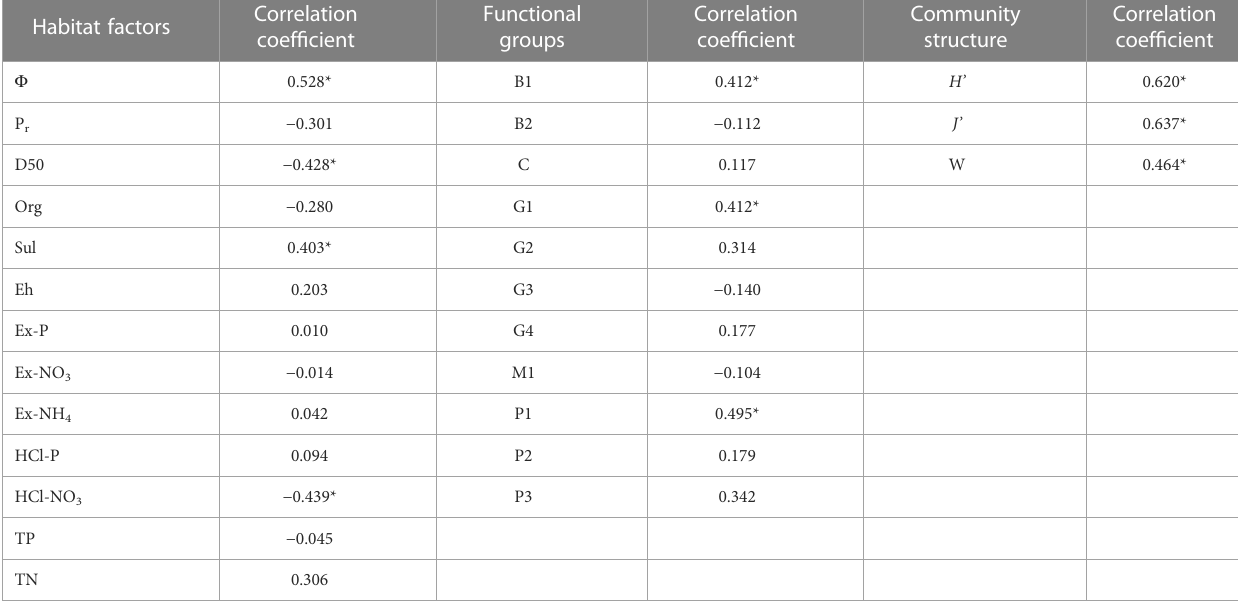
TABLE 6 Correlation of Manila clam and other functional groups, habitat factors, and community structure (M represents the biomass of Manila clam; j , Pr, D50, Org, Sul, Eh, Ex-P, Ex-NO 3 , Ex-NH 4 , HCl-P, HCl-NO 3 , TP, and TN represent water content in sediment, porosity, particulate size, organic matter content in sediment, sul fi de concentration in interstitial water, redox potential of sediment, exchangeable phosphorus content in sediment, exchangeable nitrate content in sediment, exchangeable ammonia content in sediment, hydrochloric acid leachable phosphorus content in sediment, hydrochloric acid leachable nitrogen in sediment, total phosphorus content in sediment, and total nitrogen in sediment, respectively; B1, B2, G1, G2, G3, G4, P1, P2, P3, M1, and C represent the biomass of functional groups B1, B2, G1, G2, G3, G4, P1, P2, P3, M1, and C, respectively; H ’ , J ’ , and W represent the Shanon – Wiener diversity index, Pielou ’ s evenness index, and the statistics of the ABC curve, respectively).